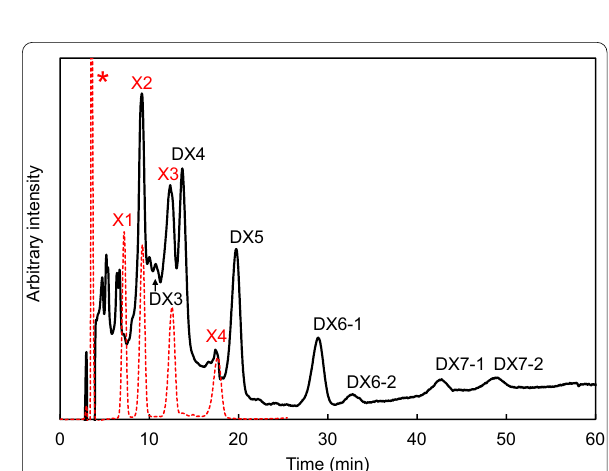
Fig. 6 Chromatogram of the hydrolysate from StXyl10 and StXyl11. The hydrolysate was separated by a Sugar-D column (4.6 with a flow rate of 1.0 mL/min using isocratic elution with 75% acetonitrile and detected with an RI detector. Standards, X1–X4 and DX3 and DX4. The DPs of the sugar peaks eluted later than X4 (DX5– DX7-2) and were estimated by their retention